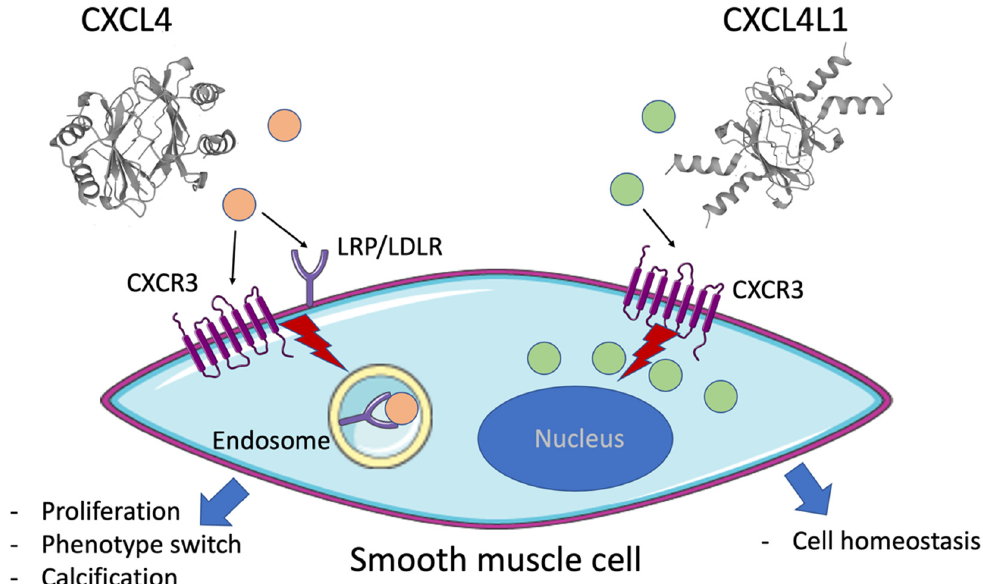
Figure 7. Schematic summary of the proposed action of CXCL4 and CXCL4L1 on smooth muscle cells. CXCL4 (orange dot and ribbon structure pdb: 1PF9Q) is taken into the cells by the action of the low ‐ density lipoprotein (LDL) receptor family proteins or lipoprotein receptor ‐ related protein (LRP) into endosomes. CXCL4 ‐ induced signals might be transmitted through both CXCR3 [4] and LRP [20], leading to proliferation, phenotypic alterations and calcification. CXCL4L1 (green dot and ribbon structure pdb: 4HSV) is present endogenously and is not taken up by SMC, but may induce cell signaling through CXCR3 [6]. It is postulated that CXCL4L1 might be involved in cell homeostatic processes.